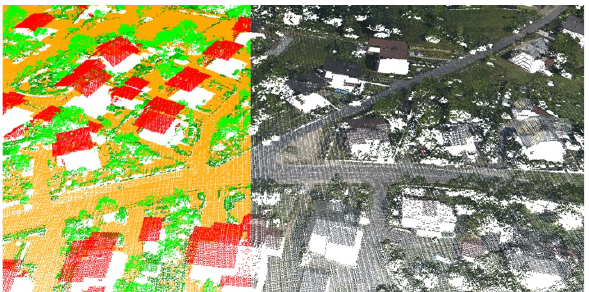
Figure 5 . Part of ALS point cloud. Left – classified. Right – colorized with RGB aerial